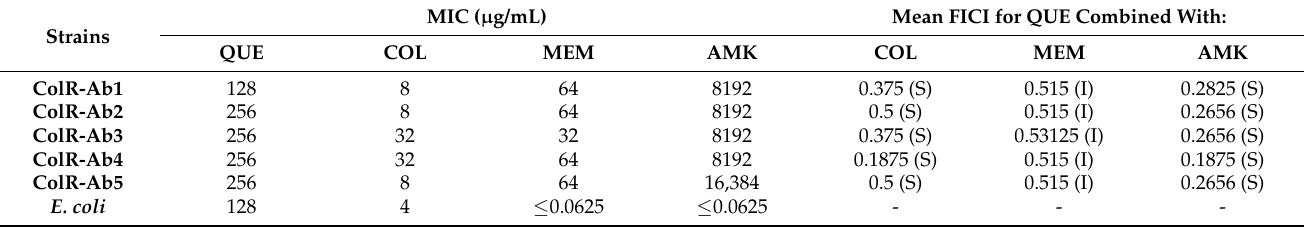
Table 1. Results of the antibacterial activities of QUE, COL, AMK, and MEM, and their combination against strains of